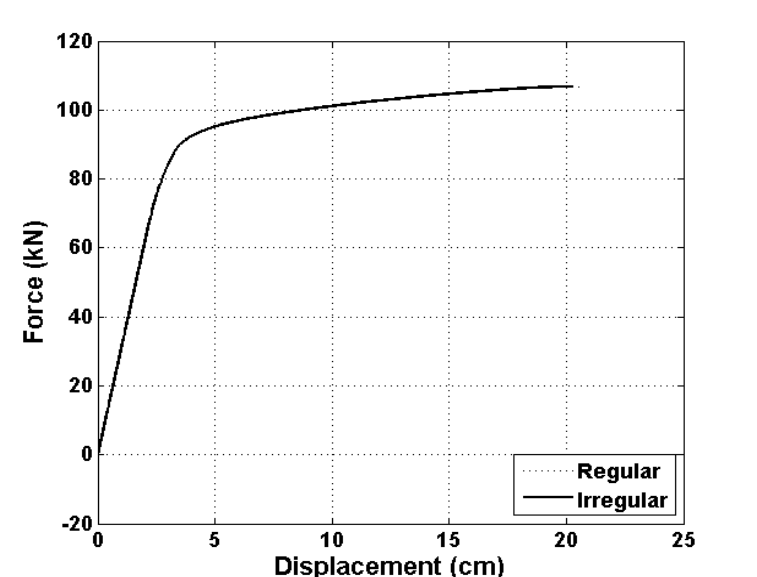
Fig. 3. Regular and Irregular Structural Push Curve for 1st